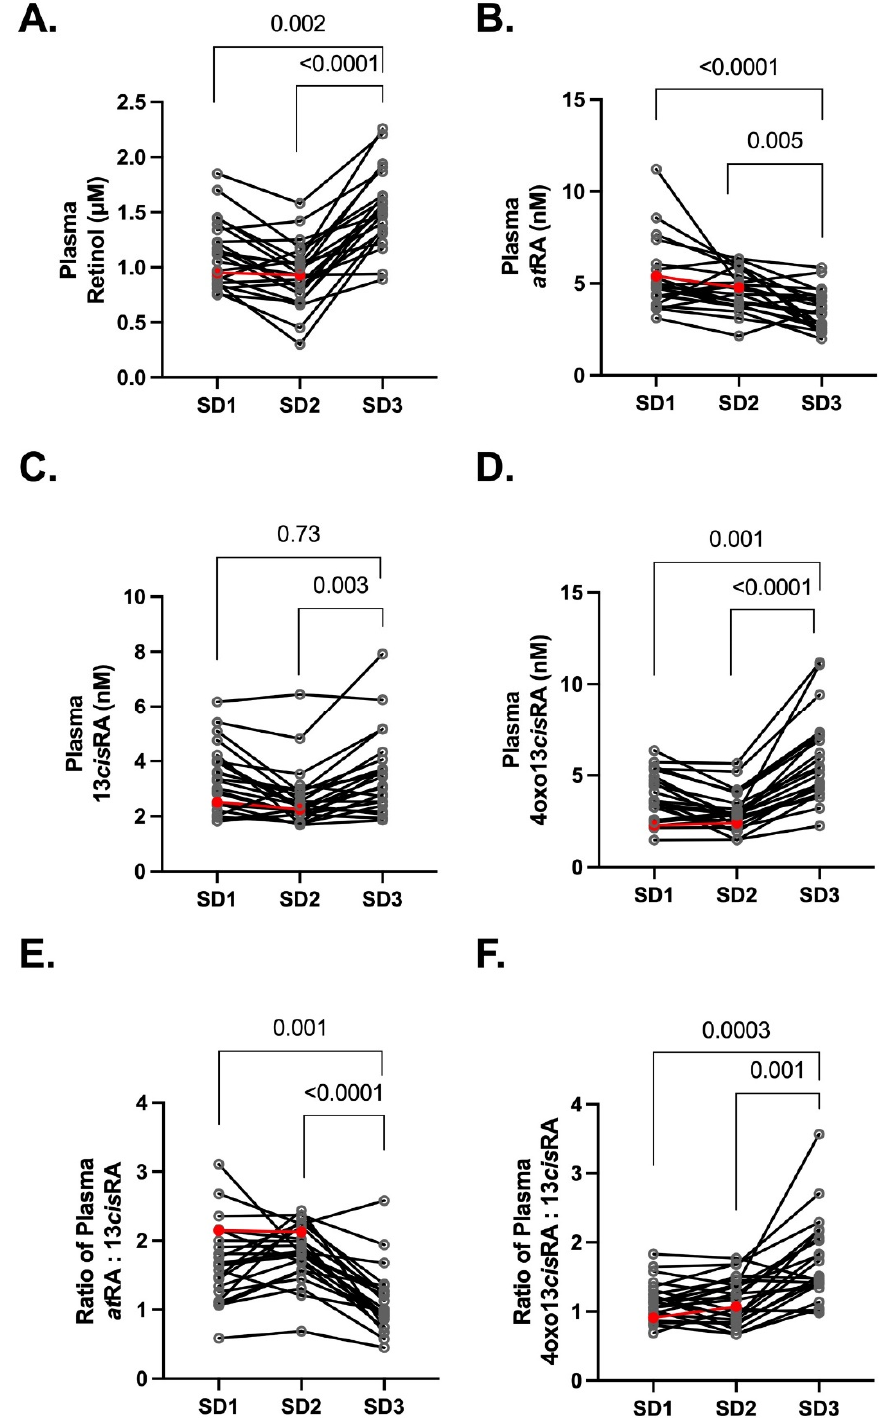
Figure 2. The plasma retinoid (( A ) retinol ( B ) at RA ( C ) 13 cis RA ( D ) 4oxo13 cis RA) concentrations are altered in normal healthy pregnancies ( n = 23) at 25–28 weeks gestation (SD1) and 28–32 weeks gestation (SD2) compared to 3–4 months PP (SD3). The ratio of ( E ) at RA to 13 cis RA was higher during pregnancy while the ratio of ( F ) 4oxo13 cis RA to 13 cis RA was lower during pregnancy. In each analysis, one subject was excluded from the statistical comparison due to insufficient sample quantity in SD3 (red symbols).